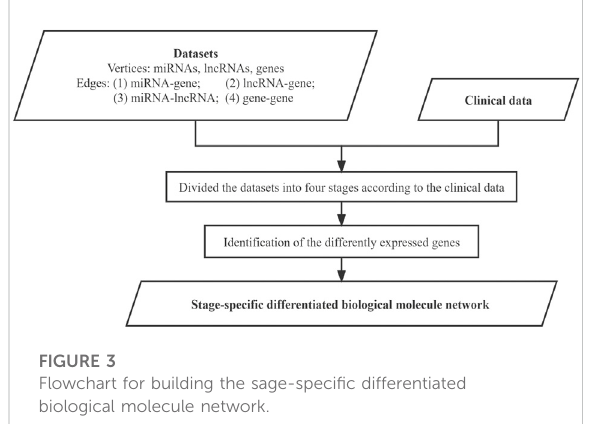
FIGURE 3 Flowchart for building the sage-speci fi c differentiated biological molecule network.